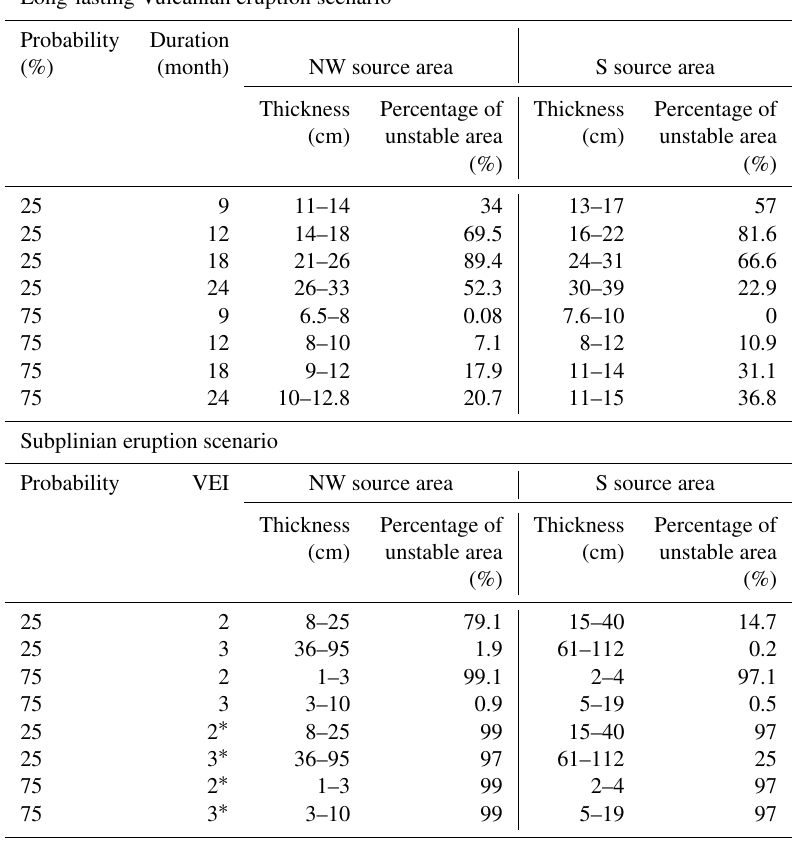
Table 4. Unstable areas (FS ≤ 1) for long-lasting Vulcanian and subplinian eruptions (VEI: K s from the literature; VEI ∗ : K s measured in the field) calculated with TRIGRS for NW and S source areas (Fig. 6). Rainfall intensity 6.4mmh − 1 with a duration of 5h. Thickness: tephra Table 3. VEI: Volcanic explosivity